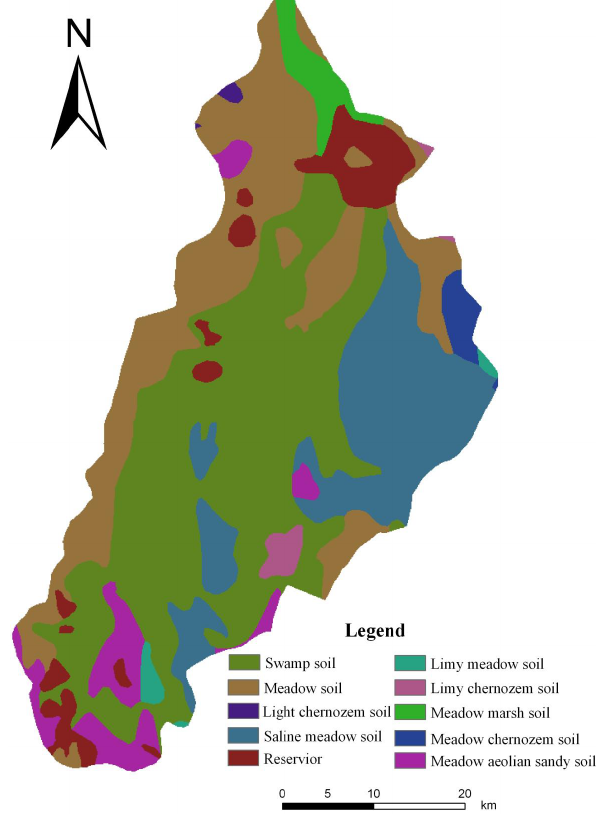
Fig. 2. Spatial distribution of soil types in the Zhalong wetland, Northeast China.